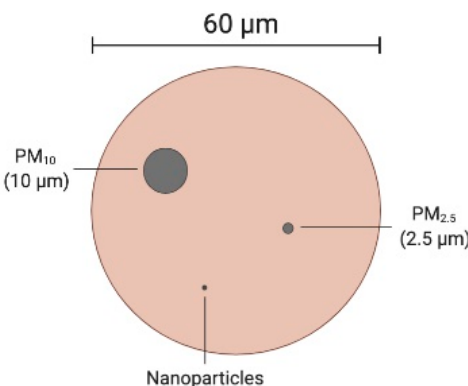
Figure 3. Schematic dimensional comparison between some particles and the cross-section of a human hair (60 µm).